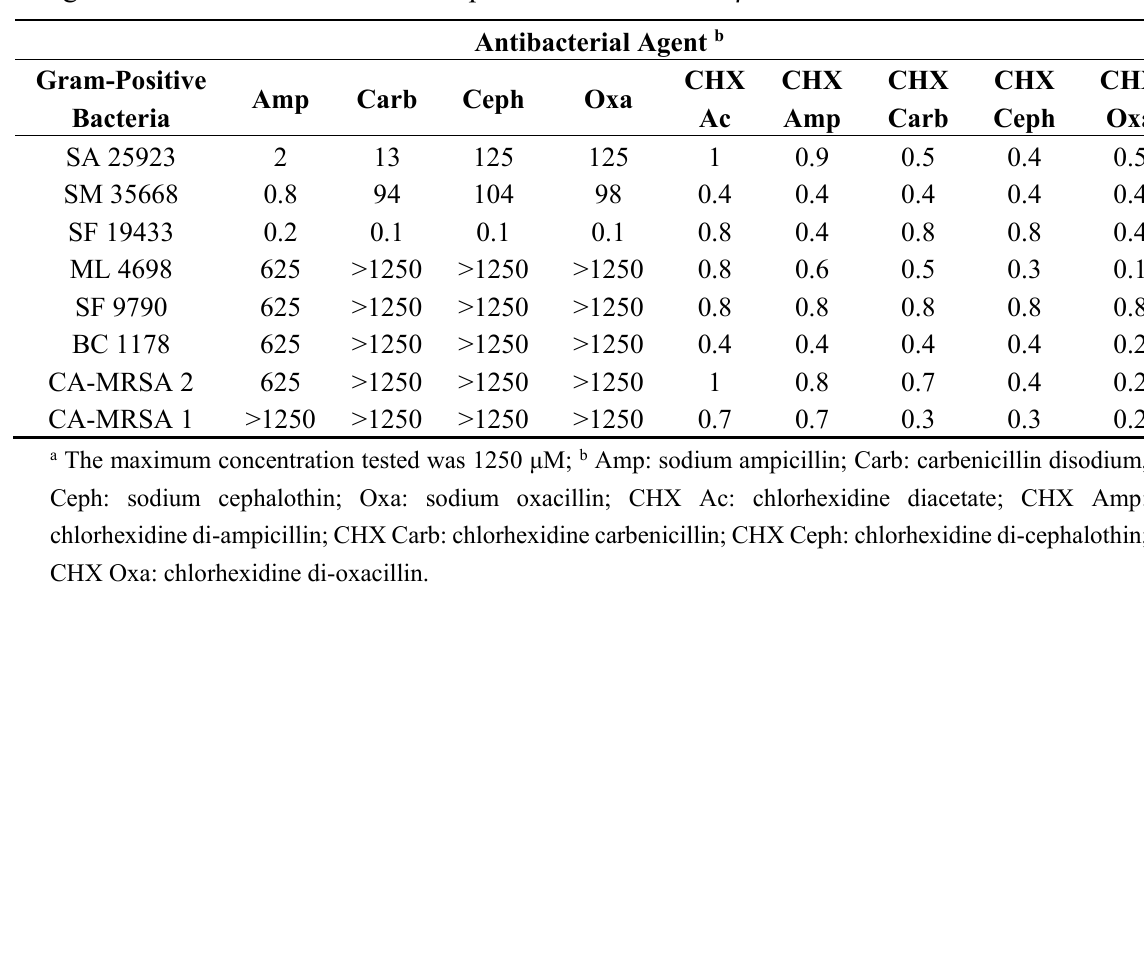
Table 3. MICs (μM) of β-lactam antibiotics, chlorhexidine diacetate and four GUMBOS against 8 clinical isolates of Gram-positive bacteria with β-lactam antibiotic resistance a